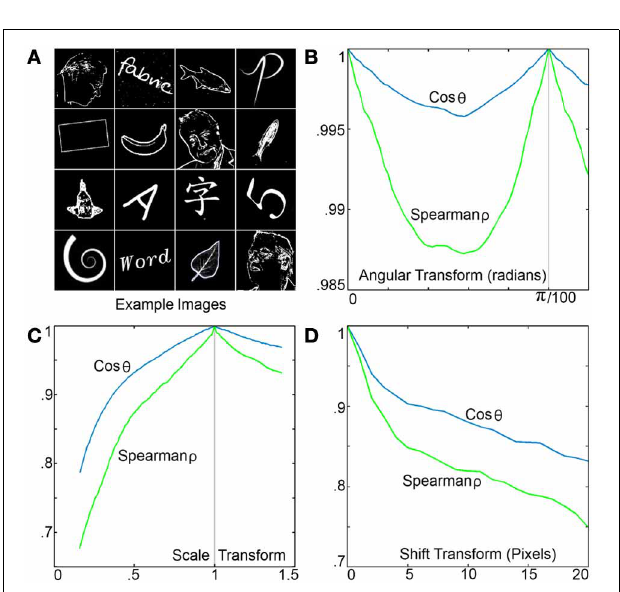
FIGURE 10 | (A) A few of the sample images used to test the RPN’s variance as a function of rotation, scale and translation. (B) Output TP variance as a function of image rotation, the illustrated pattern is repeated every π /100, note the small scale on the y axis. (C) Output TP variance as a function of image rescaling (via nearest neighbor resizing algorithm). (D) Output TP variance as a function of image translation demonstrating the high level of